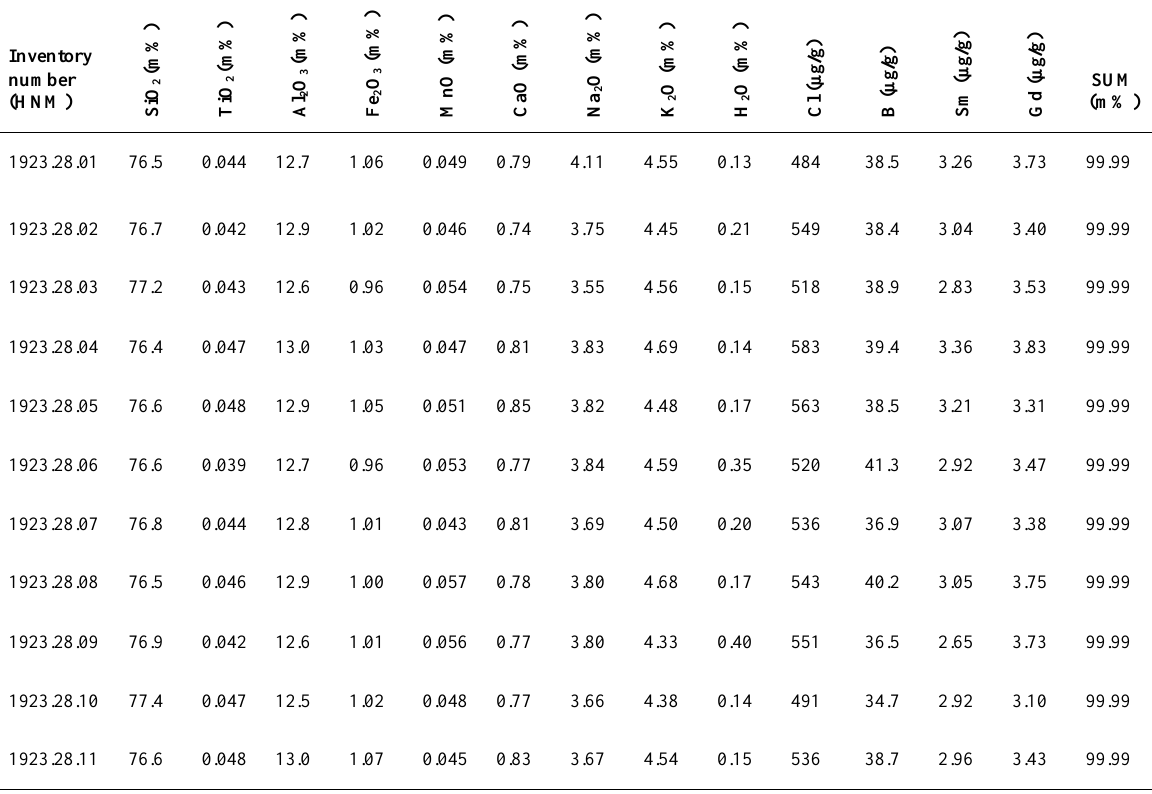
Table 2. Chemical composition data on the of the Nyírlugos cores by PGAA. Concentration values for major components are given in mass% (m%), whereas trace element concentrations are given in